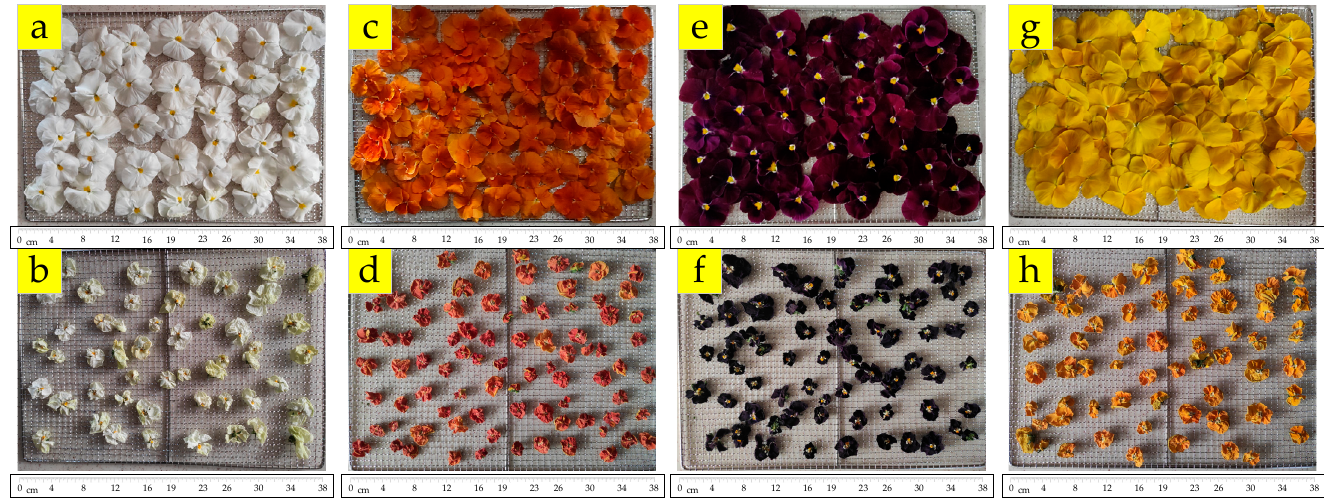
Figure 2. Fresh and dried (at 70 °C) white ( a , b ), orange ( c , d ), bordeaux ( e , f ), and yellow ( g , h ) sam-